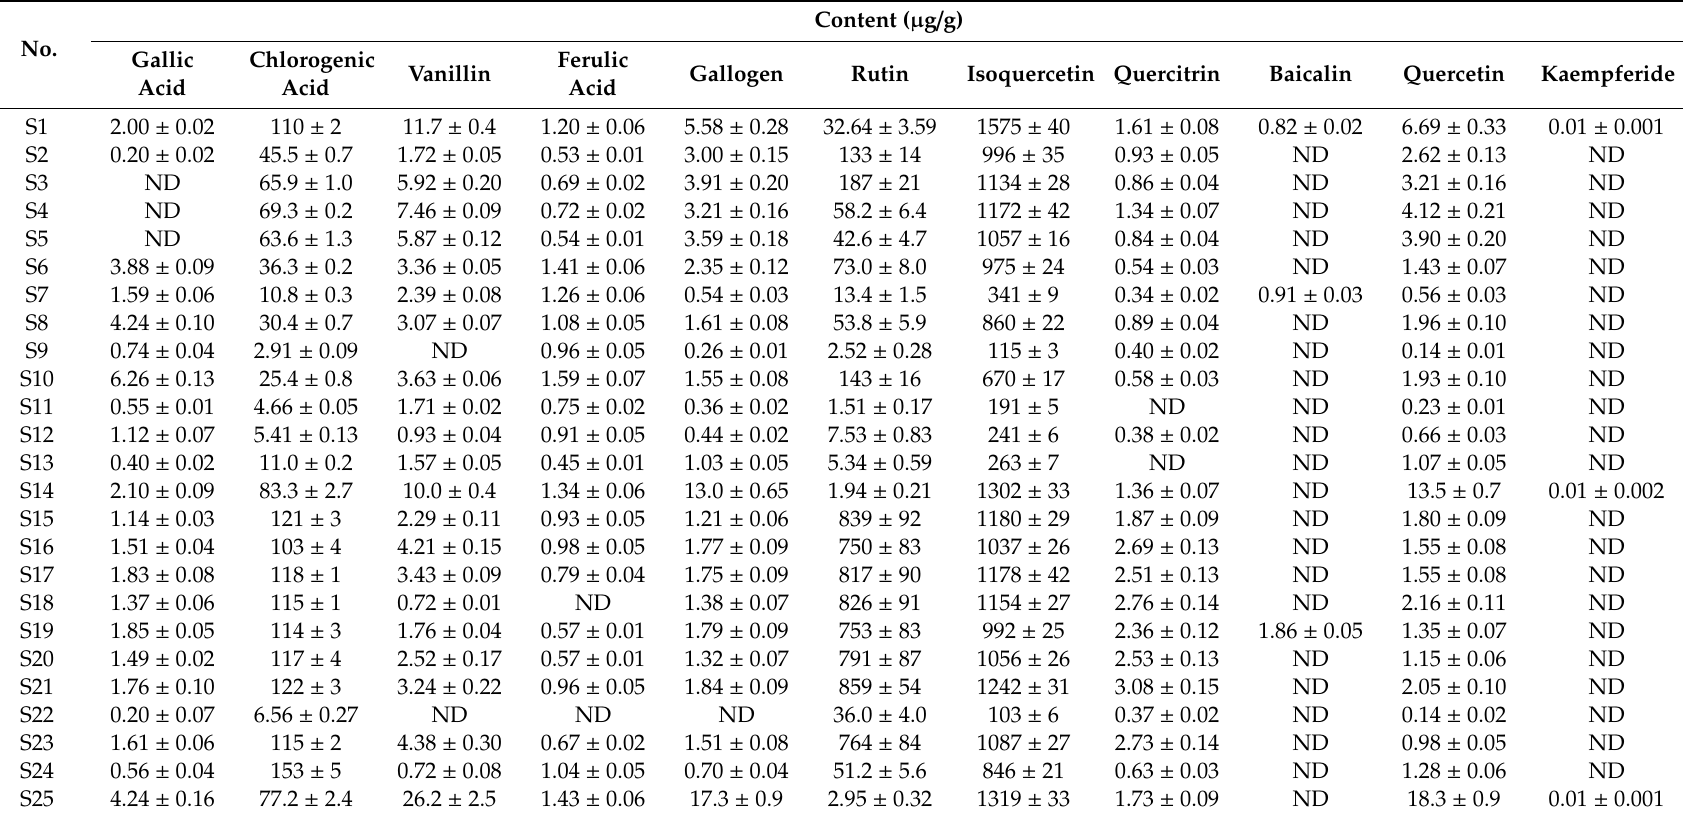
Table 5. The contents of Moringa oleifera leaves collected from di ff erent locations in Yunnan province ( n =